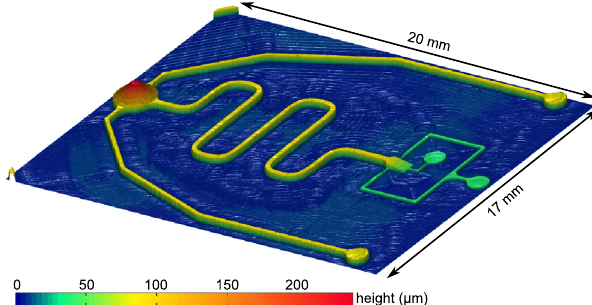
FIG. 6. Three-dimensional view of the brass mold used for the casting of the microchips. It was obtained with an optical profilometer (Zygo) by stitching images from multiple acquis- itions. The height of the coating channel is 80 μ m, and its width is 300 μ m. The slope of the bubble injector is